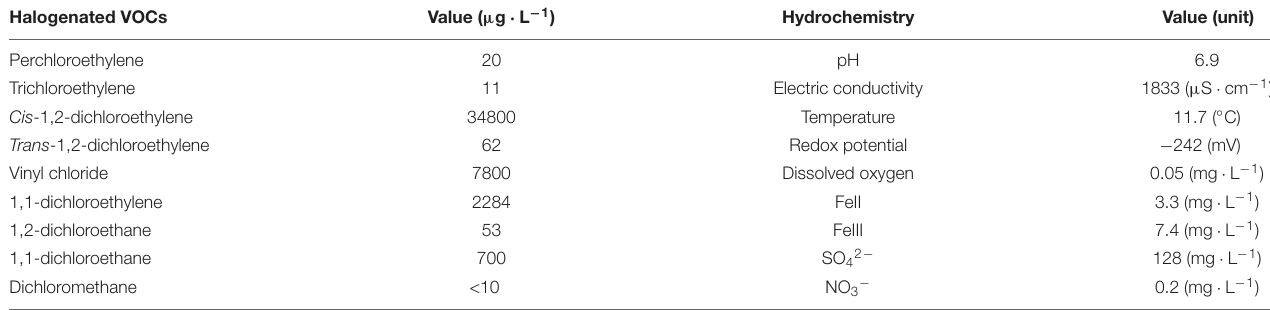
TABLE 1 | Hydrochemical characteristics of groundwater from well Pz6(10) (June 2015). Halogenated